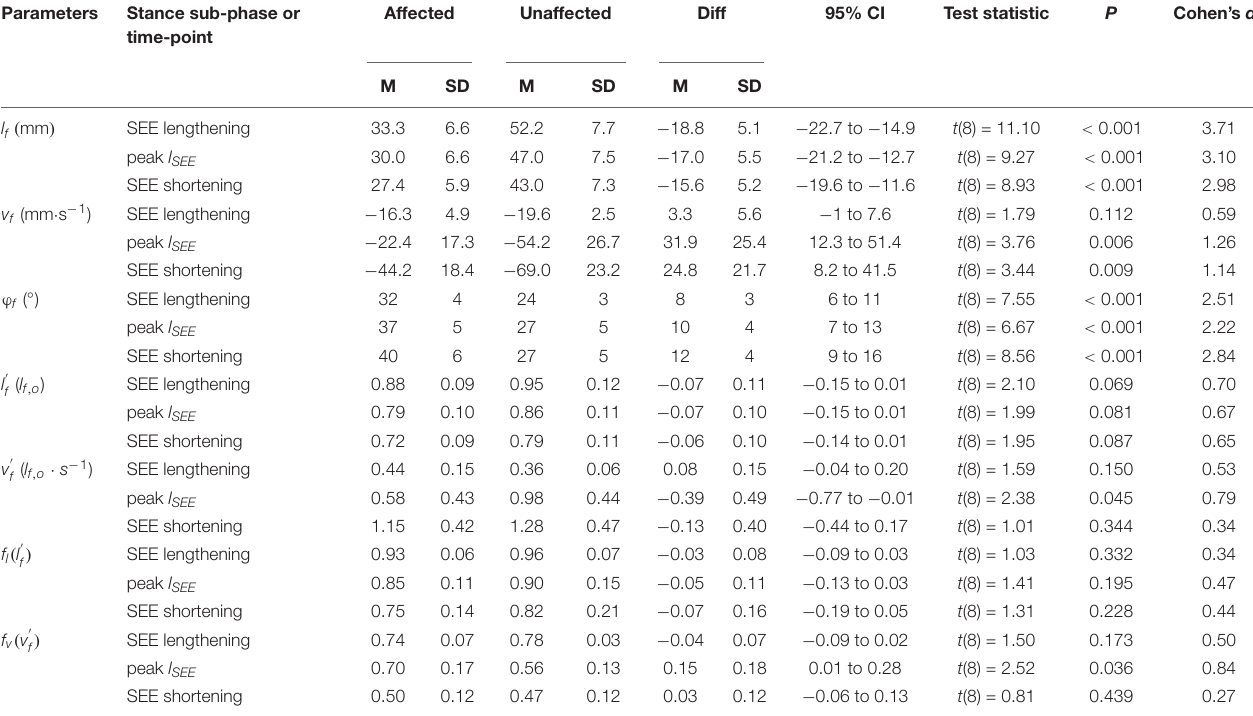
TABLE 2 | Architectural parameters of the gastrocnemius medialis muscle during walking